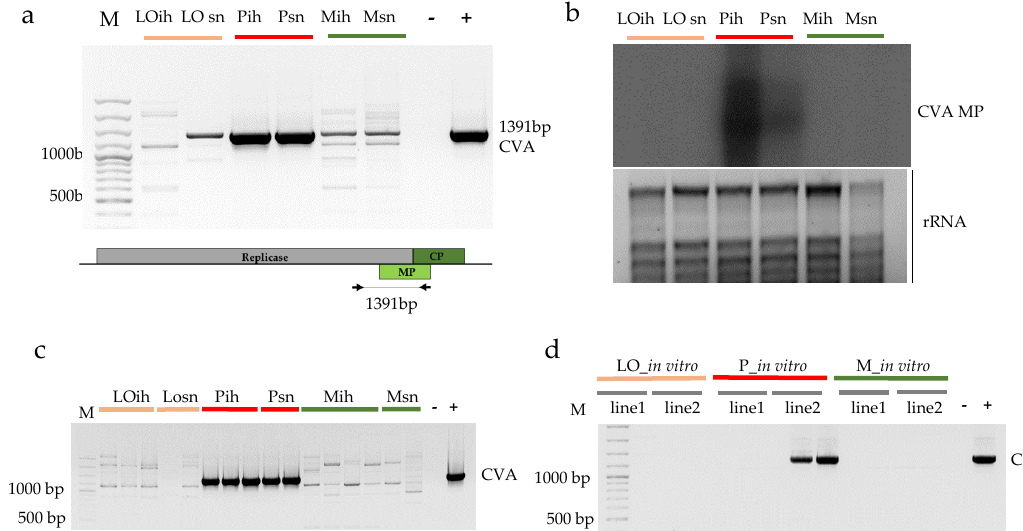
Figure 1. Validation of the presence of CVA in the samples. ( a ) RT-PCR ( b ) Northern blot of the pooled RNAs representing the sequenced libraries: LO-Ligeti ó ri á s, P-Pann ó nia kajszi, M-Magyar kajszi, ih-isolator house, sn-stock nursery. ( a ) The lower panel represents the genome of the virus indicating the PCR amplified part; ( b ) The upper panel shows film exposed to the membrane hybridized with a CVA-specific radioactively labelled probe; the lower panel is a photo of the EtBr-stained 1.5% agarose gel from which the blot was prepared; rRNAs served as a loading control; ( c ) CVA-specific RT-PCR of the sampled individuals from which the sRNA libraries were produced; ( d ) CVA-specific RT-PCR of two batches of two different lines of the in vitro plantlets served as a progenitor of the production of the mother trees under the isolator M- 100 bp Plus GeneRuler, ( − ) negative, (+) positive